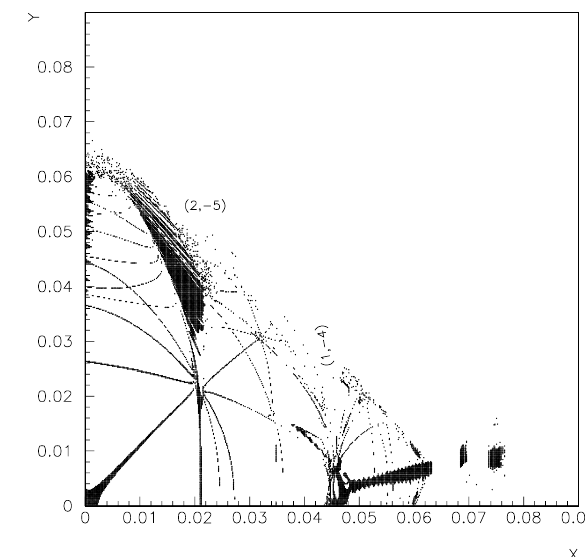
FIG. 7. Network of resonances after the single-resonance